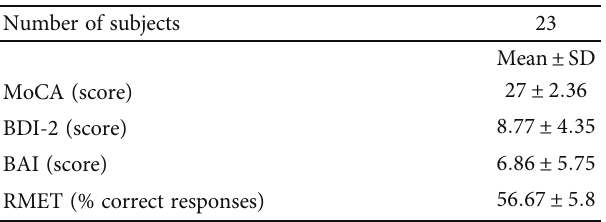
PD, Parkinson ’ s disease; HS, healthy subjects; UPDRS, Motor Section of the Movement Disorder Society Uni fi ed Parkinson ’ s Disease Rating Scale; LEED, levodopa equivalent daily dose. Table 2: PD Neuropsychological